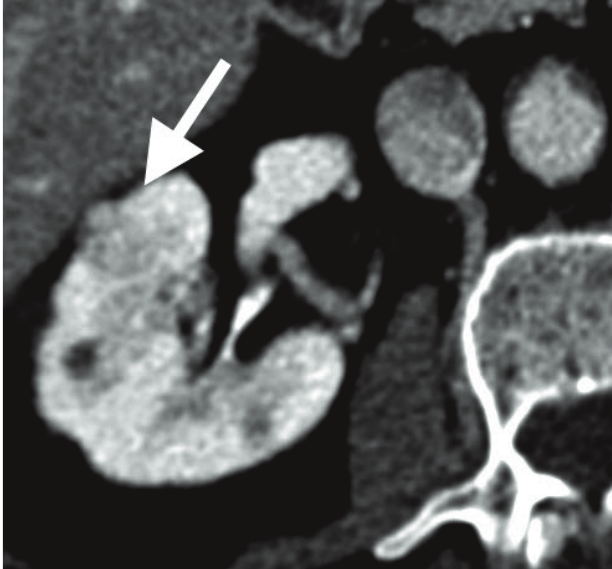
2a. Axial view after single post-triphasic contrast injection series. Fig. 2b. Sagittal